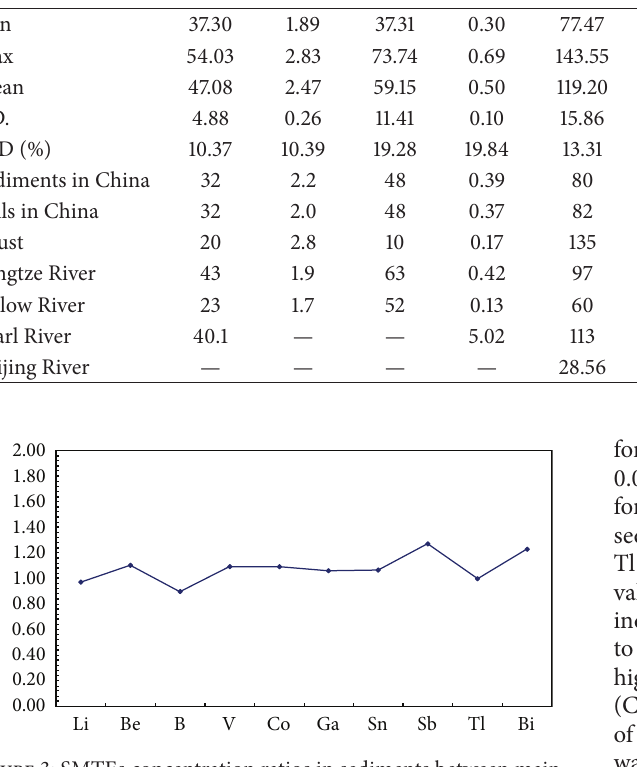
Figure 3: SMTEs concentration ratios in sediments between main- stream and